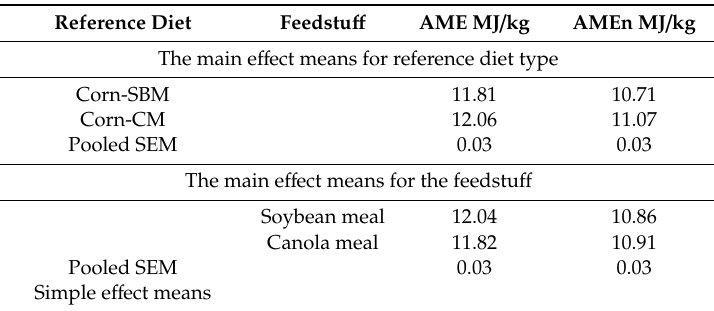
Table 4. Influence of reference diet type on apparent metabolizable energy and nitrogen-corrected metabolizable energy values of soybean meal or canola meal determined by the Regression